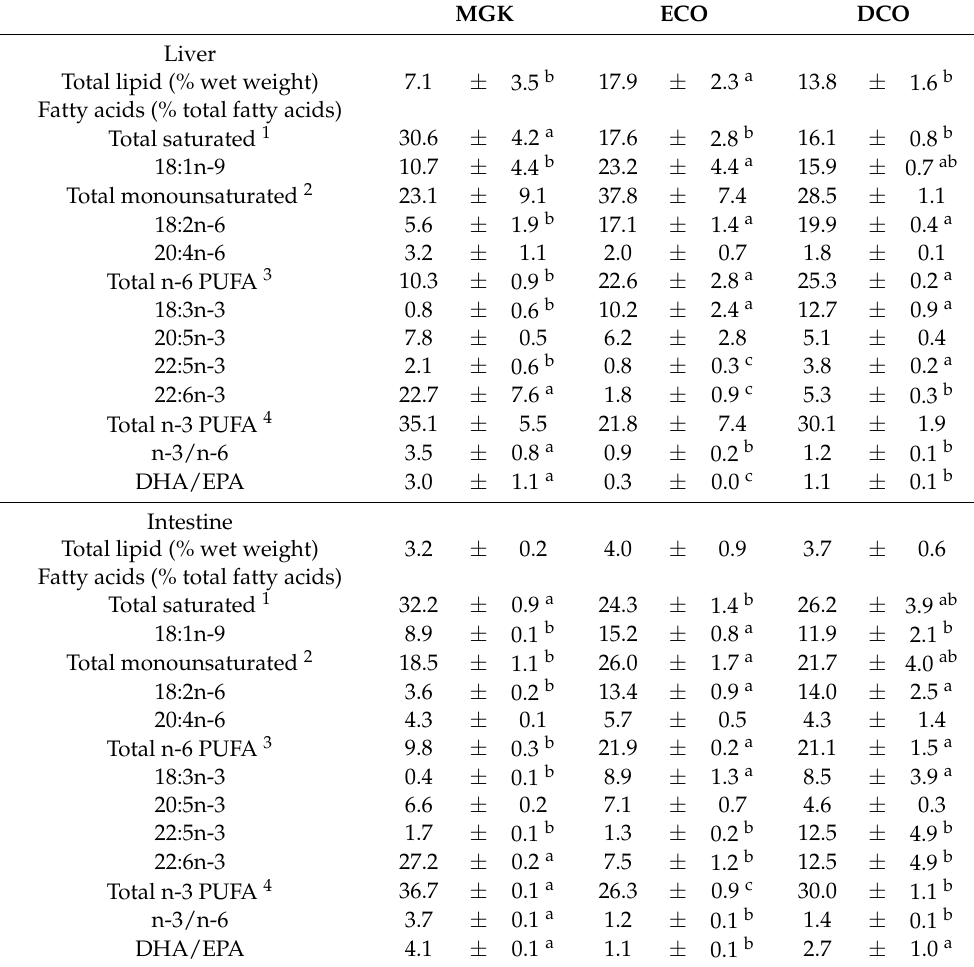
Table 5. Total lipid contents (% wet weight) and fatty acid compositions (% of total fatty acids) of Atlantic bluefin tuna ( Thunnus thynnus L.) juveniles liver and intestine after 18 days of feeding the reference (MGK) and experimental feeds containing GM Camelina sativa oils containing high EPA (ECO) or EPA + DHA (DCO) compared to the commercial reference diet (MGK). MGK ECO DCO Liver Total lipid (% wet weight) 7.1